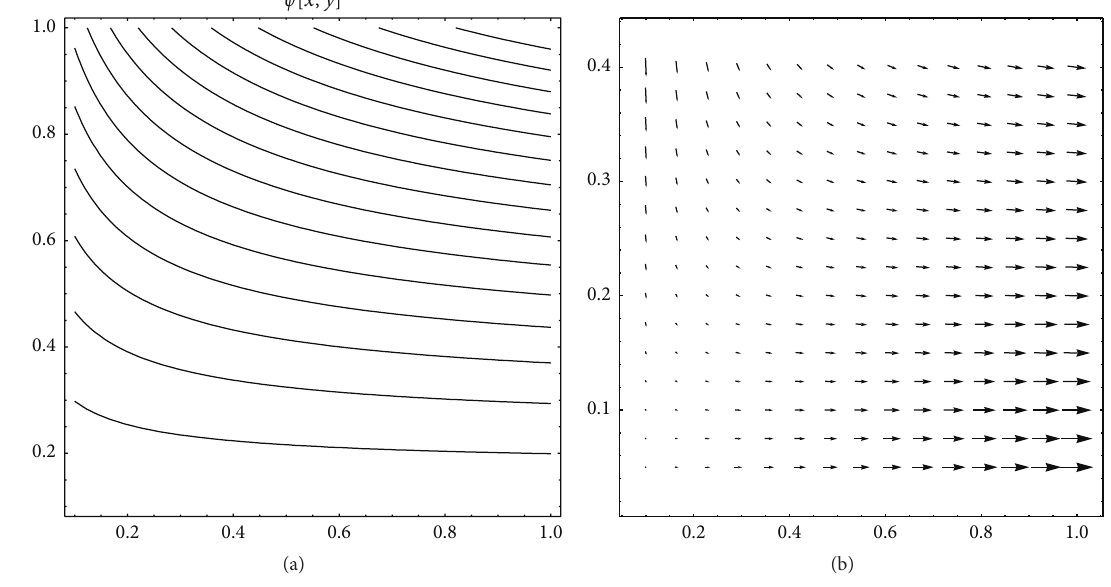
𝜉 . Also, the value of shear stress, 𝜏 12 , decreases monotonically to zero, implying that the shear stress is nonexistent force far from the